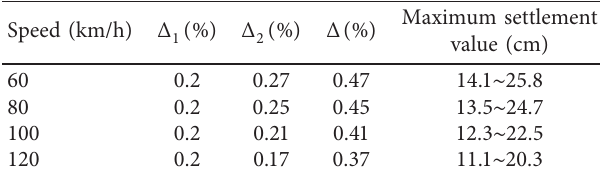
Table 6: Control criteria for differential settlement of short sub- grade at different speeds when 30m < L ≤